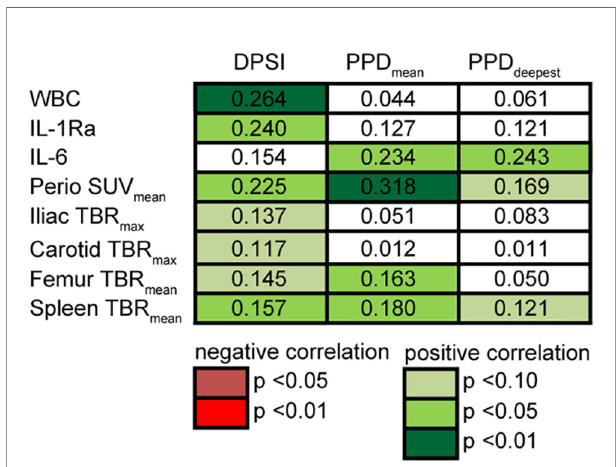
FIGURE 5 | Correlation of periodontitis severity with outcomes. Associations of DPSI score (0 – 4) and mean and deepest PPD (mm) with circulating markers and periodontal, vascular, hematopoietic [ 18 F]FDG-uptake shows strong associations. Linear regression analyses on log-transformed data accounting for age (n = 28). Multiple correlation coef fi cient R 2 of regression model noted in cells. P-values of each dependent variable are displayed by